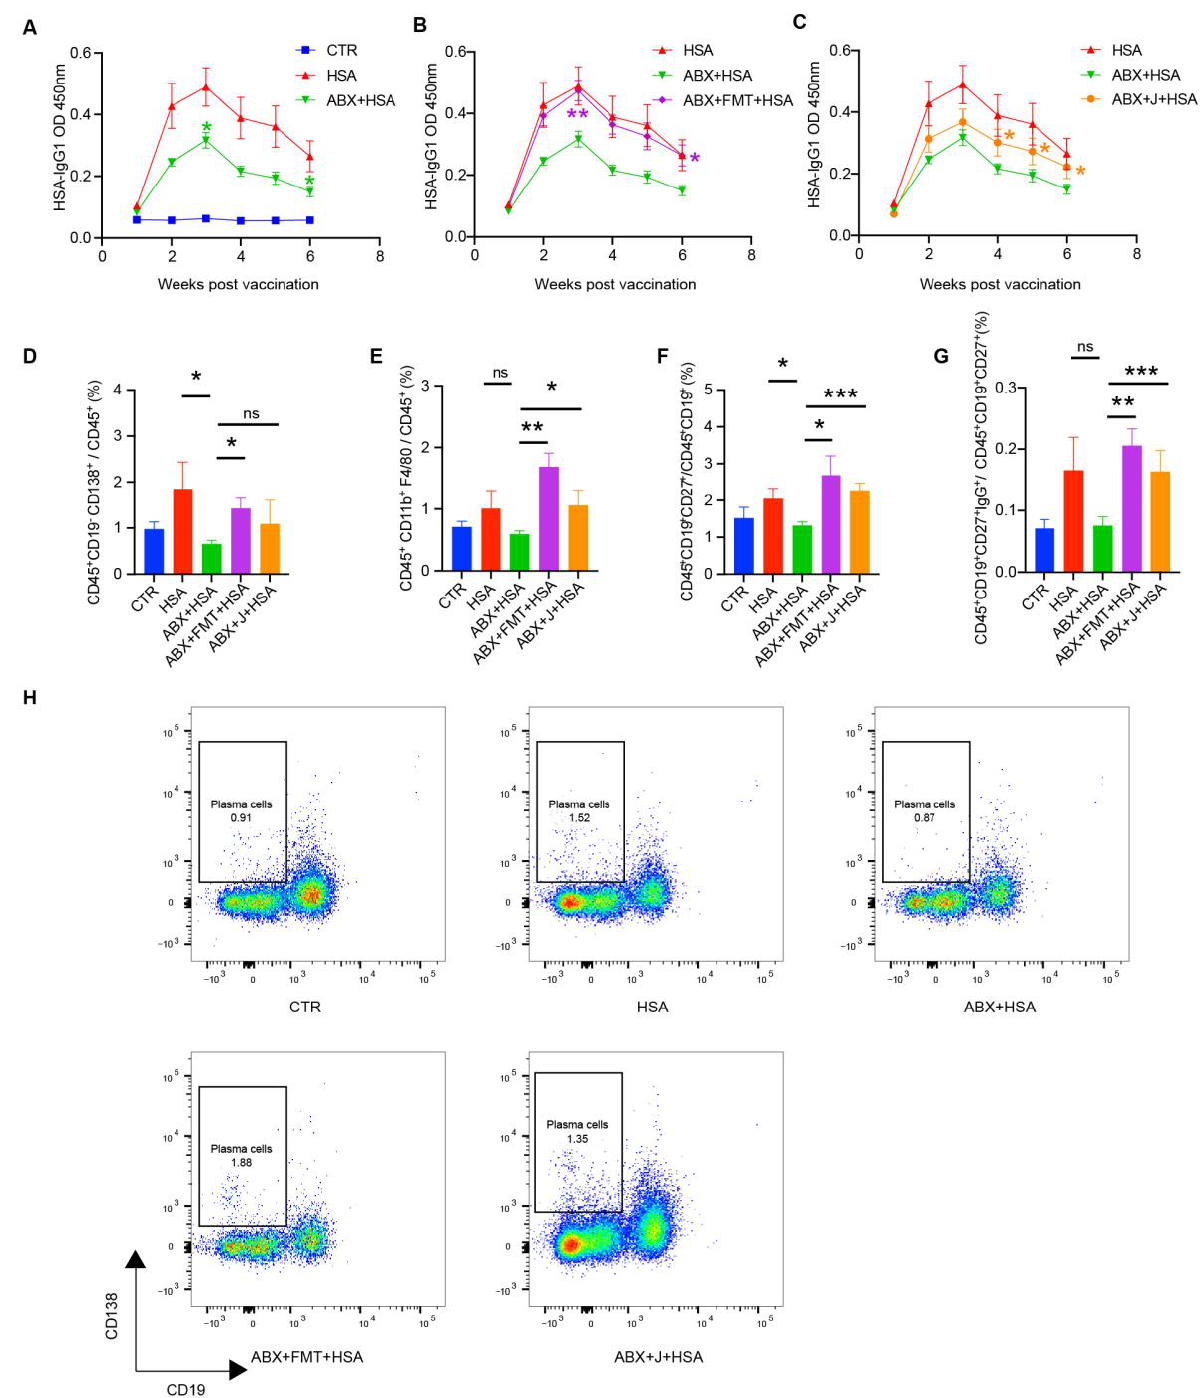
Figure 1. FMT and jujube powder recover antibody and immune cells (plasma cells, macrophages, memory B cells, and IgG memory B cells) of HSA-vaccinated mice models impaired by ABX. ( A – C ) HSA-specific IgG1 concentrations in HSA, ABX+HSA group ( A ), ABX+FMT+HSA group ( B ), and ABX+J+HSA group ( C ). ( D – G ) The percent of plasma cells ( D ), macrophages ( E ), memory cells ( F ), and IgG memory cells ( G ) in the blood of the CTR, HSA, ABX+HSA, ABX+FMT+HSA, and ABX+J+HSA groups ( H ). Representative flow cytometry results showing the percentage of plasma cells in blood from mice of each group. no significance (ns), p > 0.05, * p < 0.05, ** p < 0.01, *** p < 0.001.